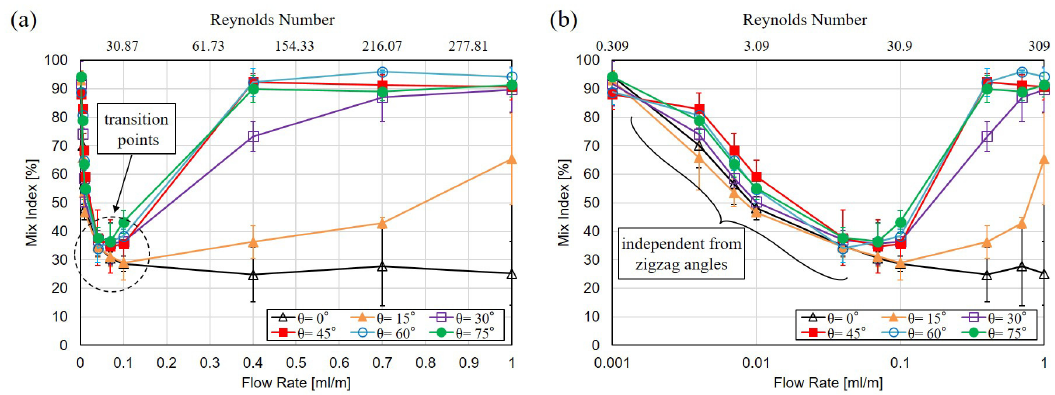
Figure 9. Experimental results of mixing performance under 6 different zigzag angles, including θ = 0 ◦ ,15 ◦ ,30 ◦ ,45 ◦ ,60 ◦ and 75 ◦ . The marks and error bars represent the average values and standard deviations among three independent tests. ( a ) The analyzed results of mixing index with different zigzag angles at different flow rates. ( b ) The chart in logarithmic scale for the flow